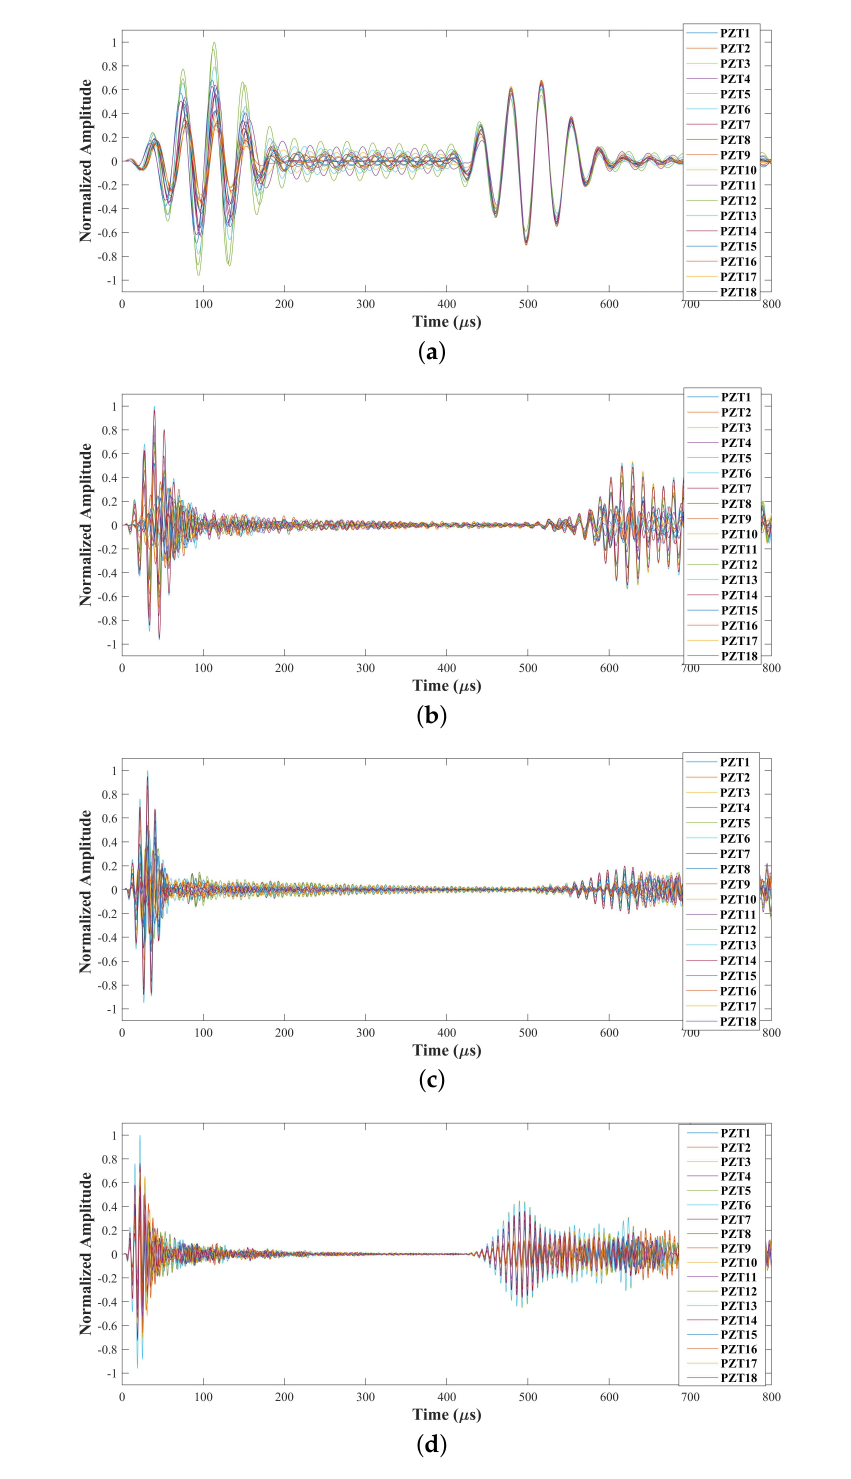
Figure A1. FE outputs of all PZTs at: ( a ) 25 kHz M4, ( b ) 80 kHz M9, ( c ) 100 kHz M11, ( d ) 155 kHz